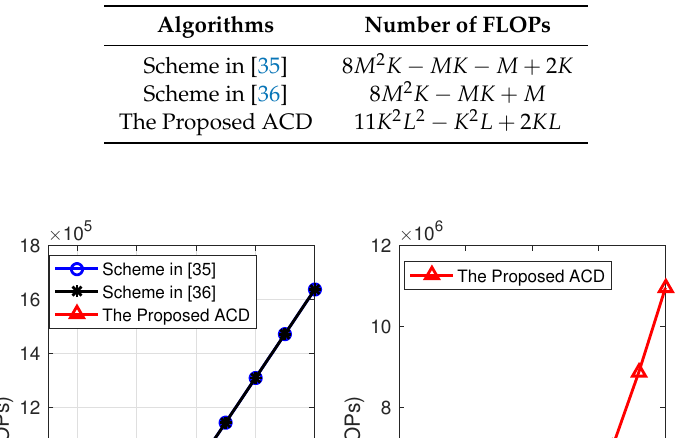
Table 1. Complexity comparison.